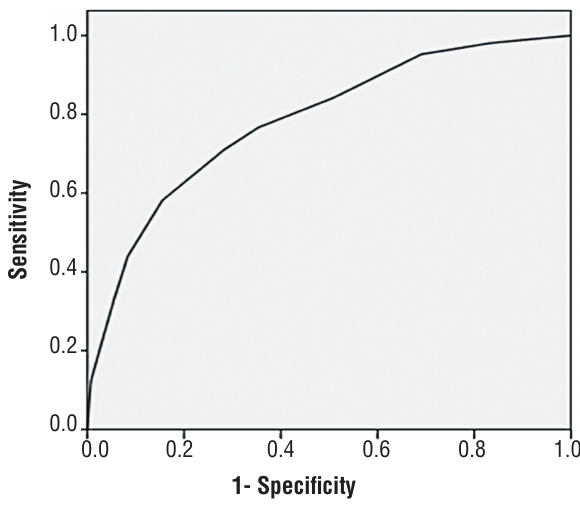
Table 3 - variable score according to OR logistics regression analysis.